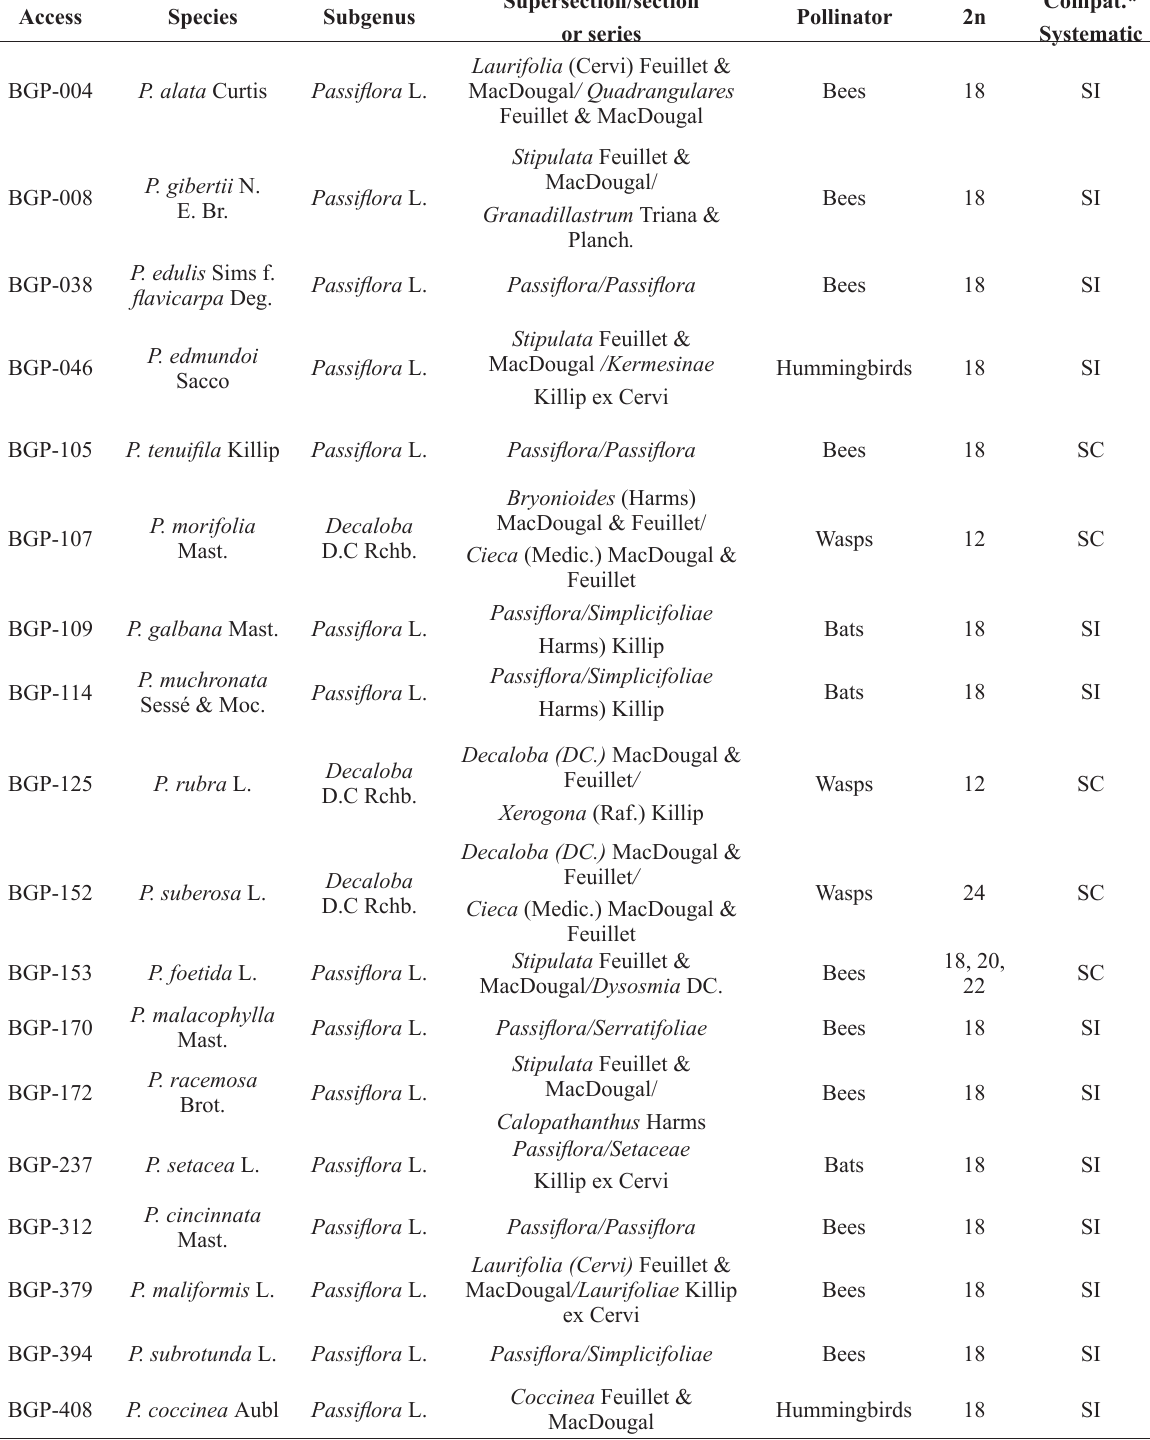
List of 18 Passiflora s pecies of the genus Passiflora L. used in this